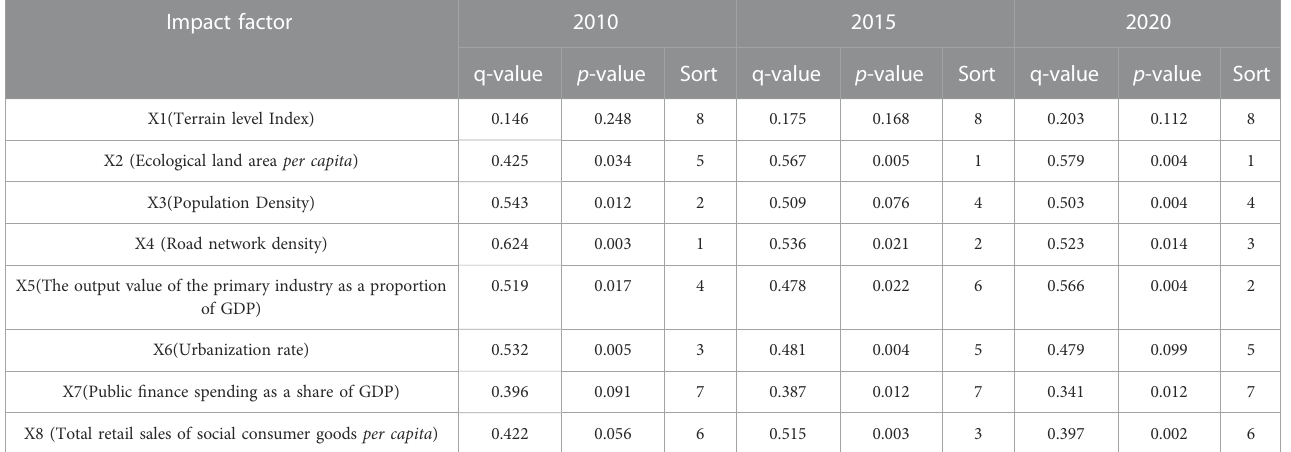
TABLE 9 The intensity of Impact Factors from 2010 to 2020.